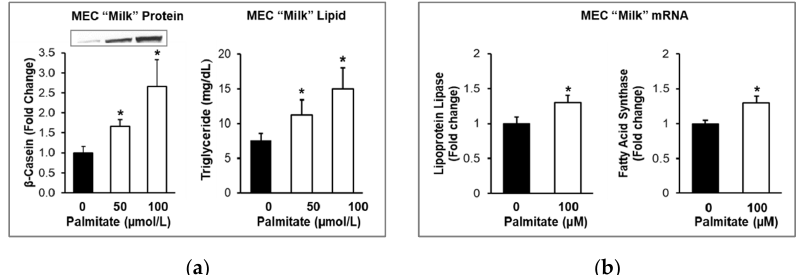
Figure 6. Effects of Palmitate on Secreted Milk Protein β -casein and Milk Lipid. MECs were treated with varying doses of palmitic acid added to the lactation medium in the basolateral chamber for 48 h. The apical medium was analyzed for ( a ) protein expression of β -casein (representative immunoblot shown) and triglyceride concentration. ( b ) mRNA expression of lipid enzymes. Each treatment was performed in quadruplicate, and differences between treated and untreated MECs were compared using ANOVA with Dunnett’s post-hoc test. Values are fold changes (Mean ± SE); * p < 0.001 treated vs. untreated MECs.